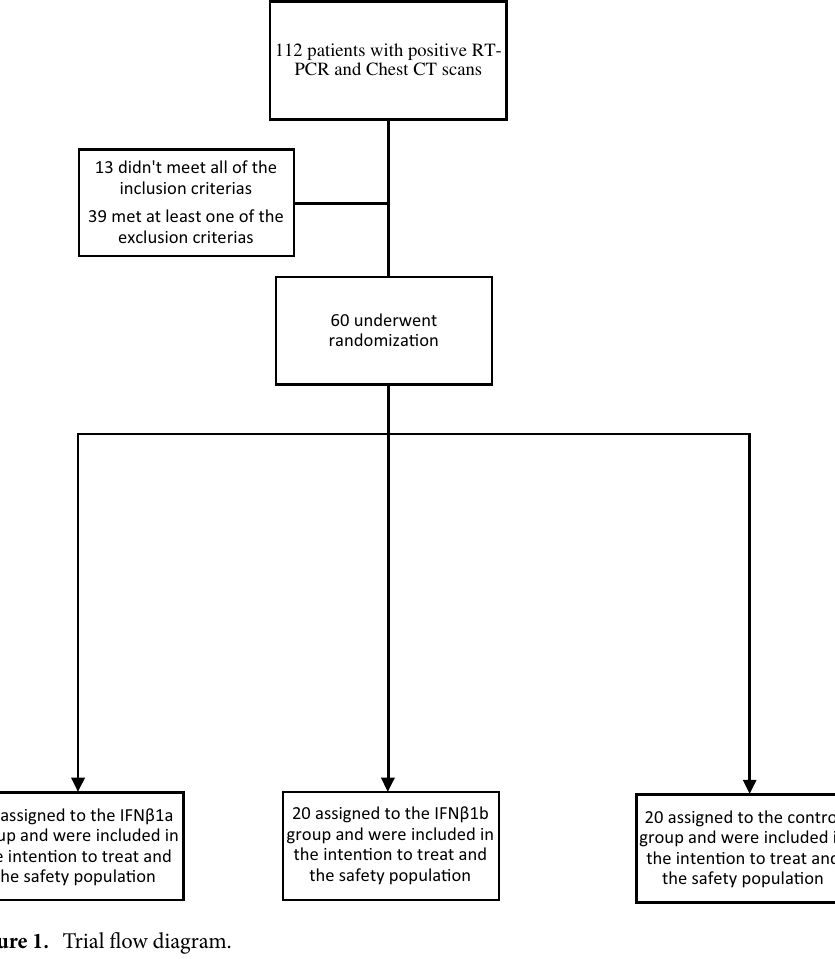
Figure 1. Trial flow